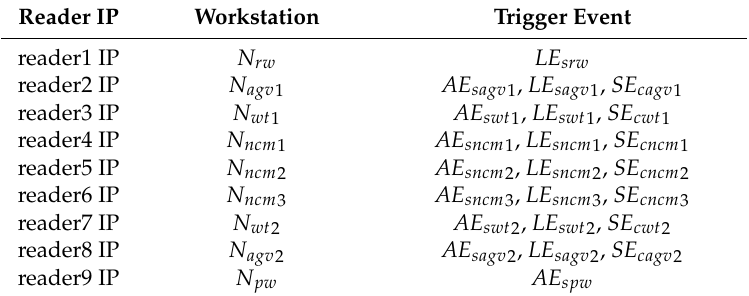
Table 3. The corresponding relationships of reader IPs, workstations and trigger evens. Reader IP Workstation Trigger